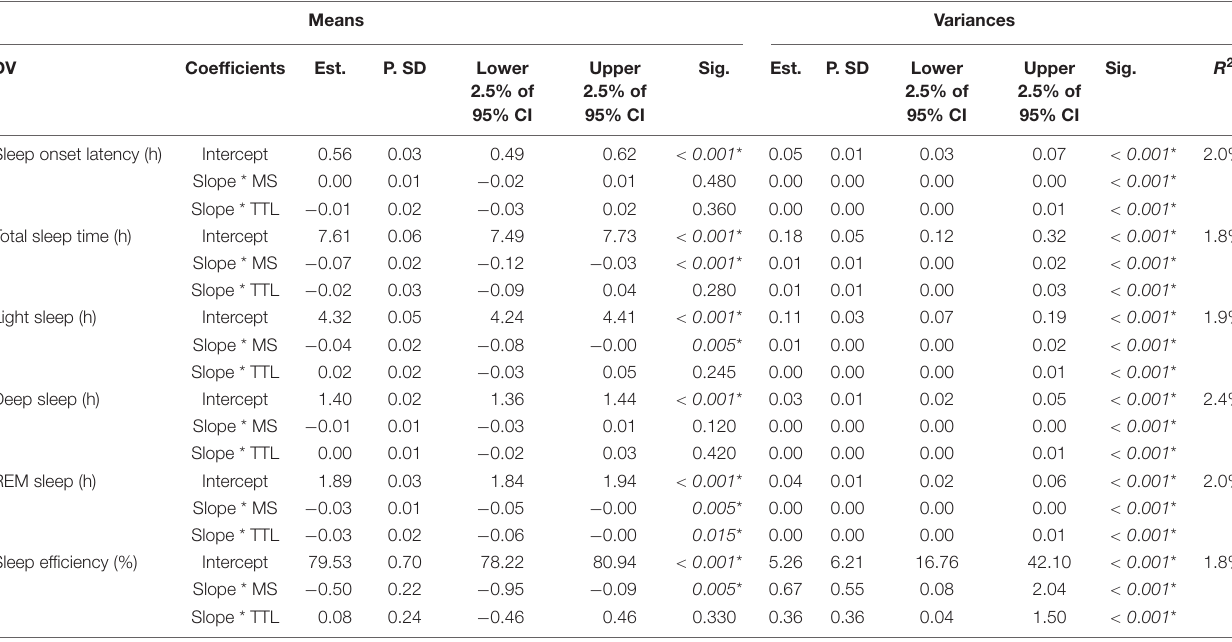
TABLE 4 | Two-level random intercept and random slope models investigating the effect of mental strain and training load (IVs) on sleep variables (DVs) and whether these effects vary between individuals in 56 junior endurance athletes.